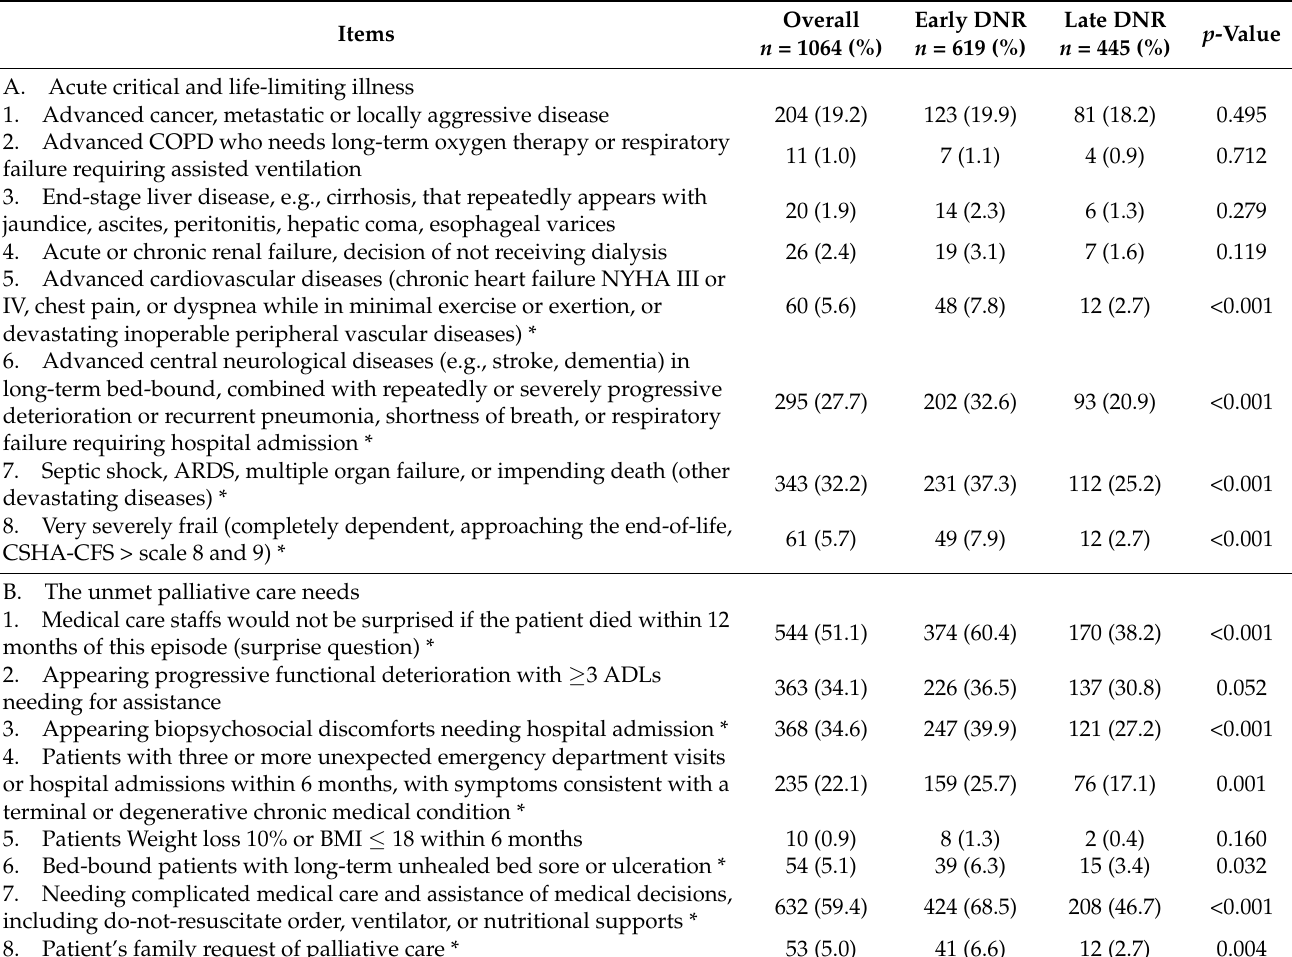
Table 1. The screening items for needs assessment of palliative care consultation among 1064 patients at the time of